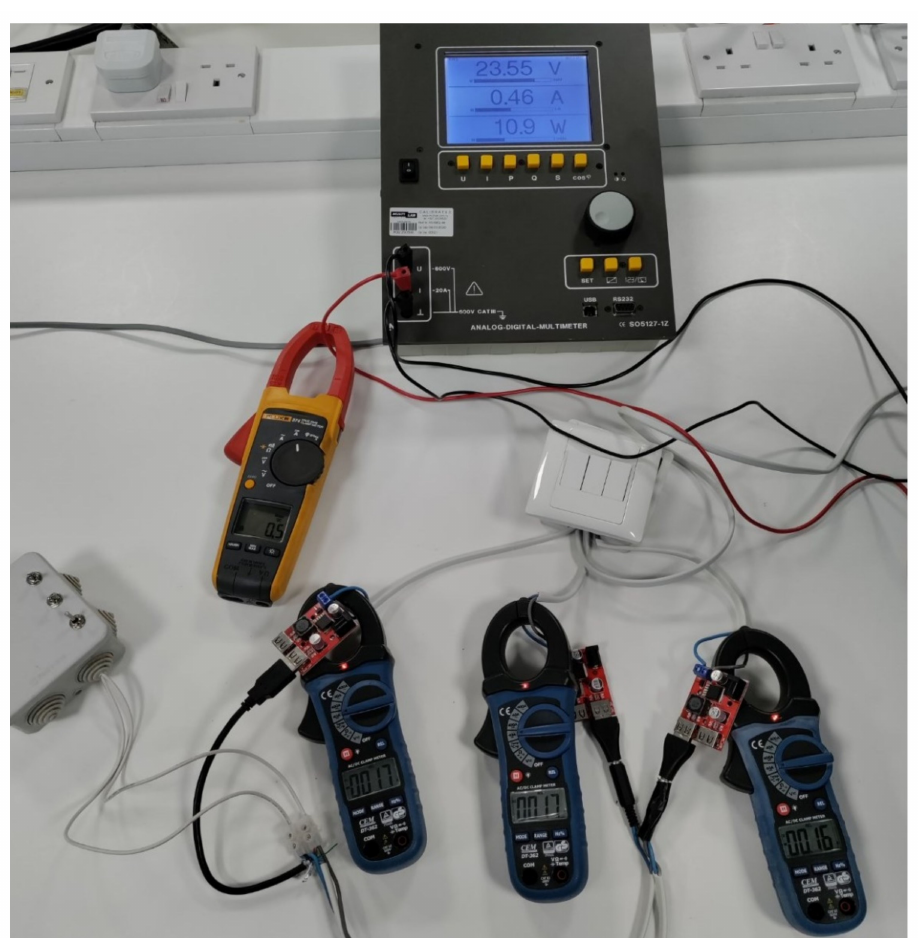
Figure 9. Experimental set-up of load sharing between parallel buck